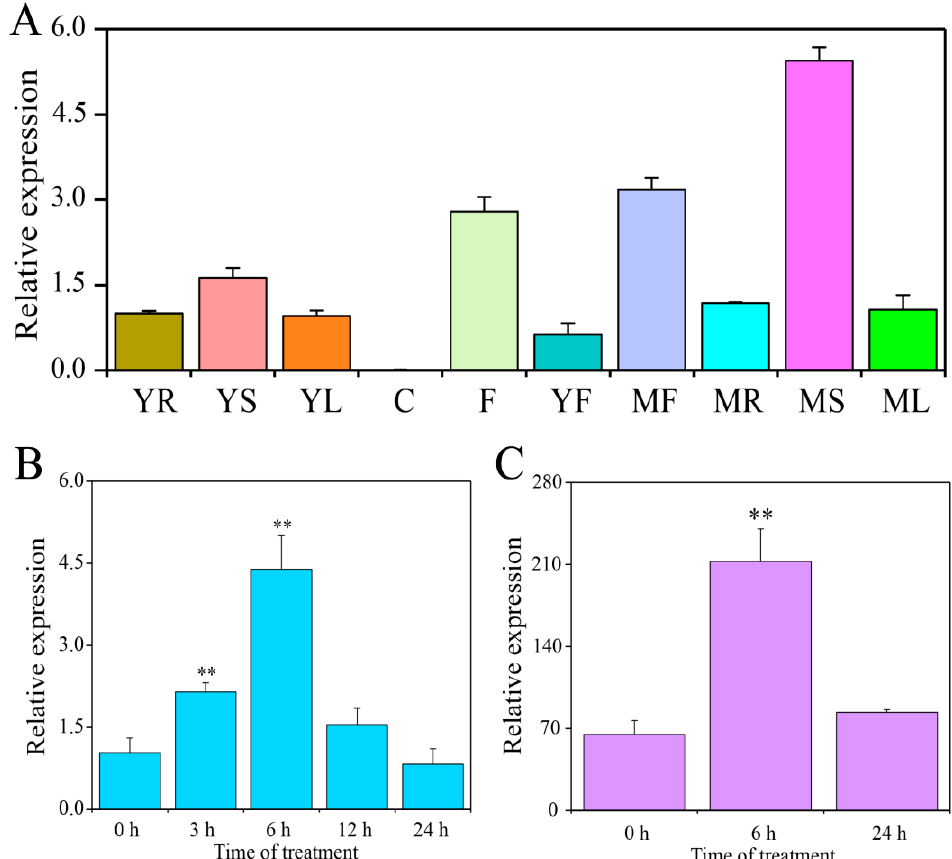
Figure 3. Expression analysis of CaSPDS in various tissues and in response to cold stress. ( A )qRT-PCR analysis of CaSPDS in ten tissues: young root (YR); young stem (YS); young leaf (YL); cotyledon (C); flower (F); young fruit (YF); mature fruit (MF); mature root (MR); mature stem (MS); mature leaf (ML). Data are expressed relative to YR and normalised to the reference gene (CaUbi3, AY486137). ( B ) Expression profiling of CaSPDS in response to cold stress by qRT-PCR. Pepper seedlings were subjected to cold stress at 4 °C. Leaves were sampled at 0, 3, 6, 12, and 24 h after treatment. ( C ) Expression patterns of CaSPDS in response to cold stress using available RNA-seq data. Pepper leaves were collected at 0, 6 and 24 h after 4 °C treatment. ‘**’ indicates a significant difference between the treatment and control at p < 0.01.